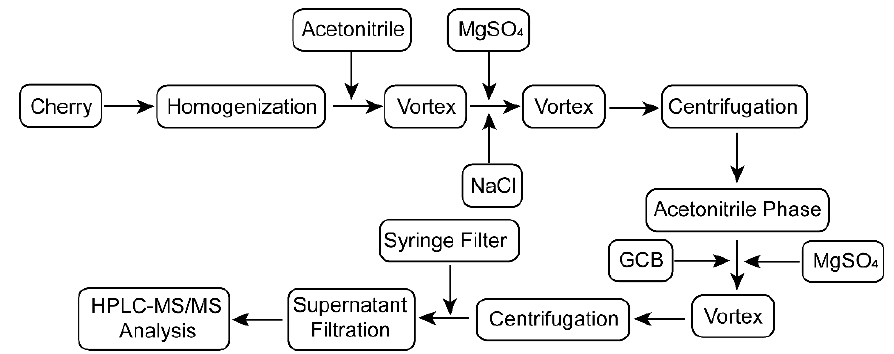
Figure 4. Flow chart of the extraction and purification process of the cherry samples.